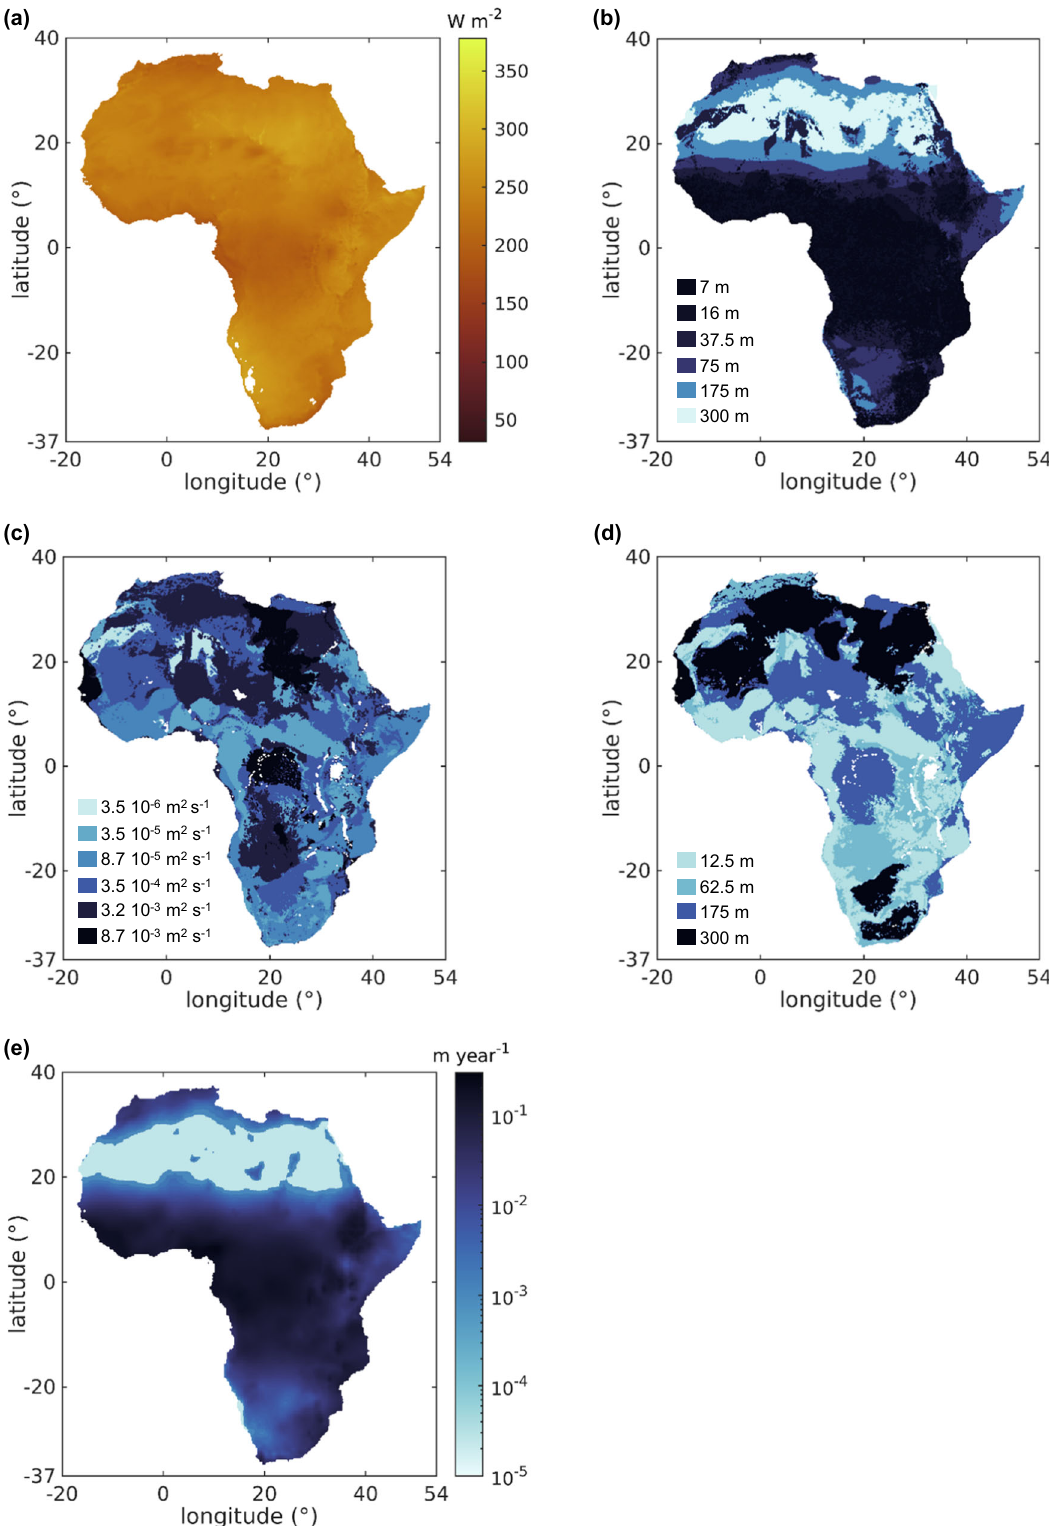
Fig. 2 Representation of selected input data. a global horizontal irradiance G gh (average over the year for 2020, yellow scale), b static water depth H b,s (blue scale), c aquifer transmissivity T (blue scale), d aquifer saturated thickness H st (blue scale), e groundwater recharge R (blue scale). Data sources are shown in Table